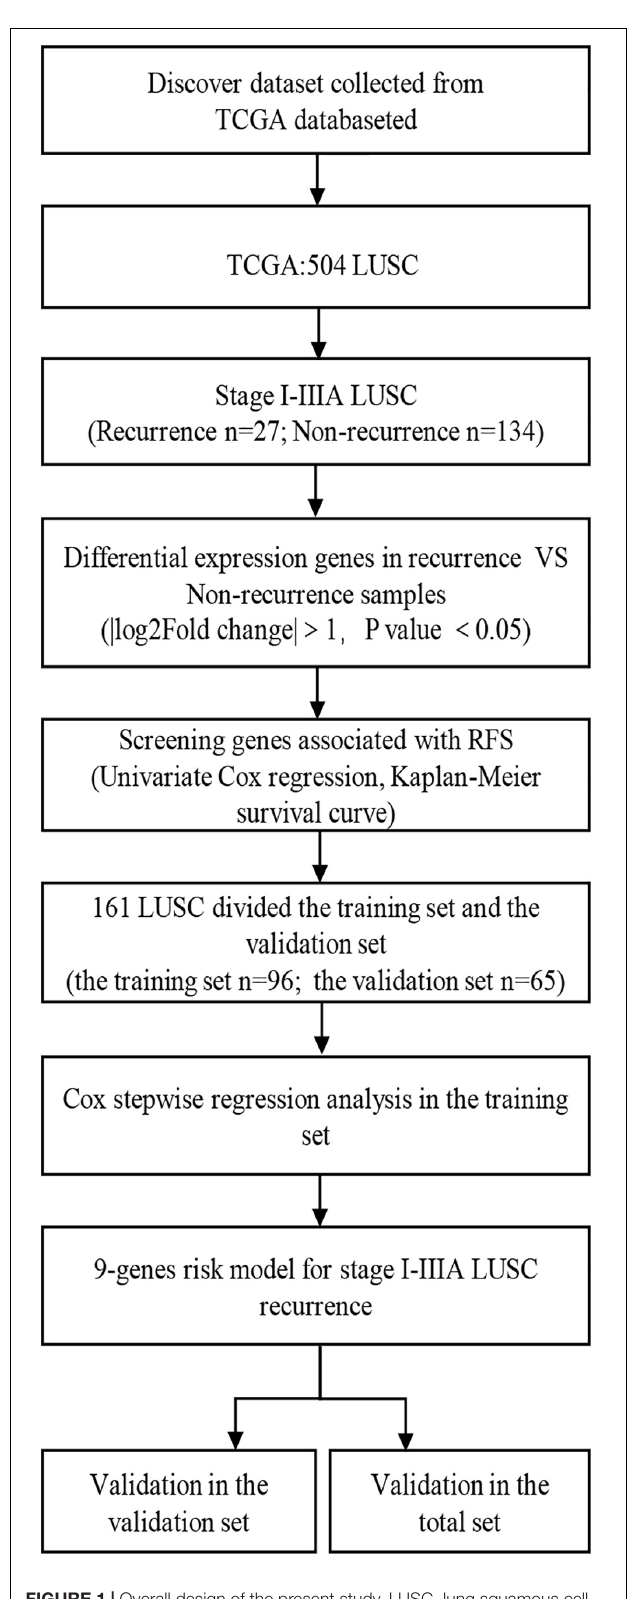
FIGURE 1 | Overall design of the present study. LUSC, lung squamous cell carcinoma; RFS, Recurrence-free